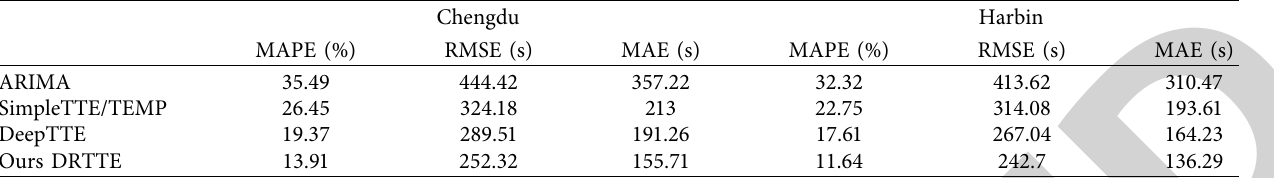
Table 4: Performance comparisons with